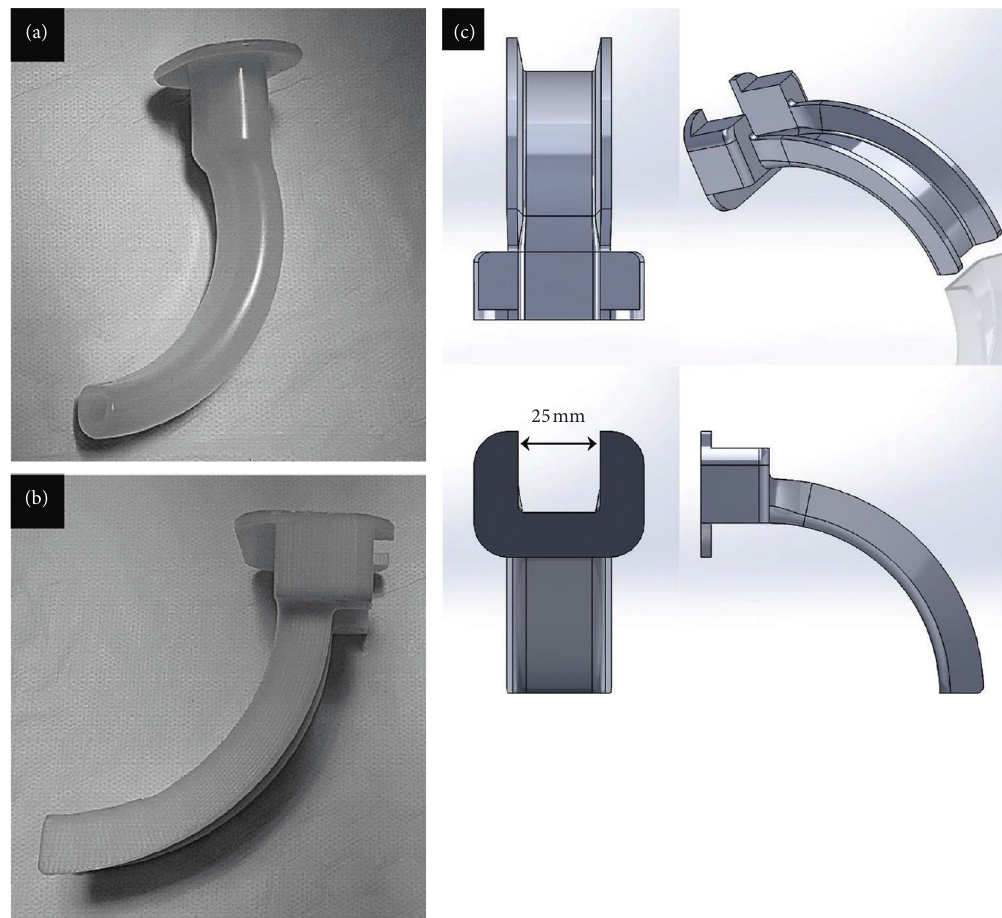
Figure 3: The conventional airway and the modified airway. Real photos of the conventional oropharyngeal airway (a) and the modified airway (b). 3D blueprint of the modified airway derived from conventional airway shows the 25 mm wide posterior channel (c). Table 1: Demographic data and intubation experience of participants with respect to the types of devices used for manikins or real patients. Variable Median (IQR) Male, n (%) 22 (61.11%)